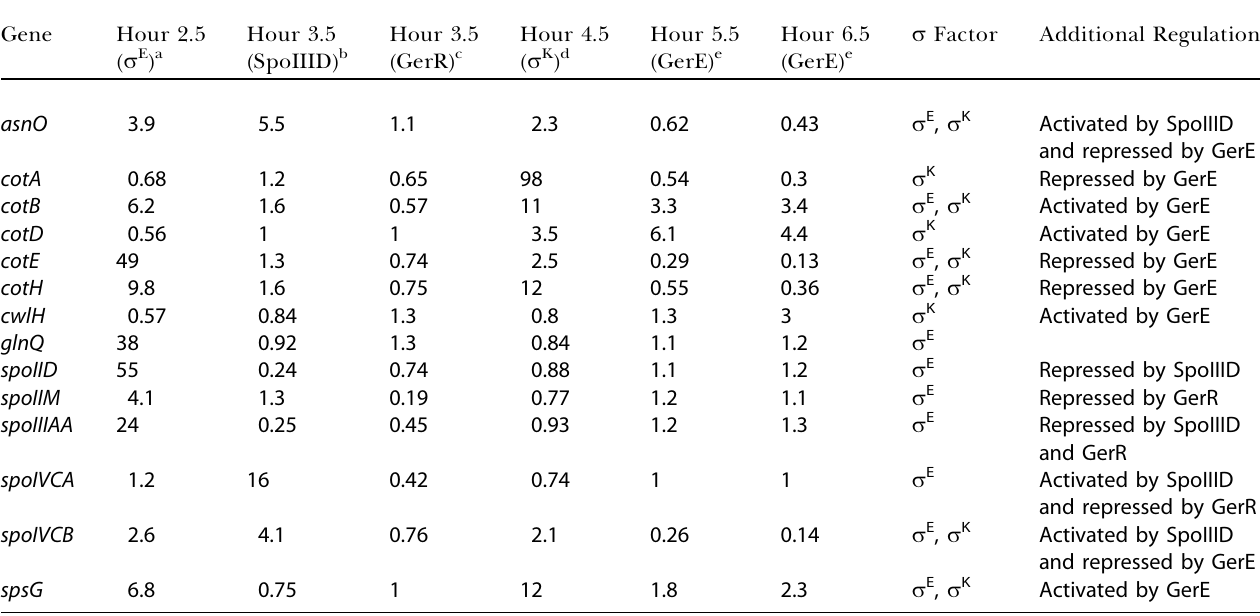
a Ratios of relative RNA levels in sigE þ versus sigE mutant. b Ratios of relative RNA levels in spoIIID þ versus spoIIID mutant. c Ratios of relative RNA levels in gerR þ versus gerR mutant. d Ratios of relative RNA levels in sigK þ versus sigK mutant. e Ratios of relative RNA levels in wild type versus gerE mutant. DOI: 10.1371/journal.pbio.0020328.t001 PLoS Biology |